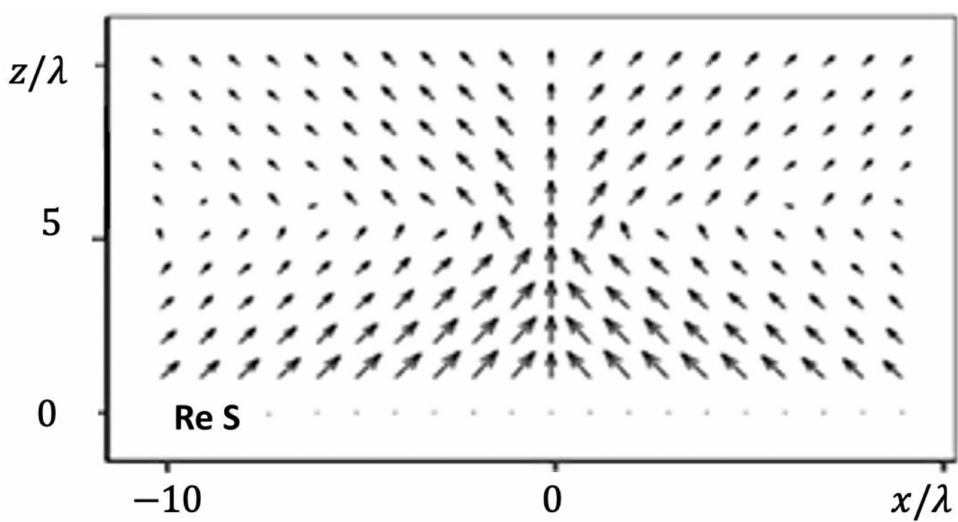
Figure 4. Spatial distribution of the real part of the Poynting vector in a lossless environment: antenna length, 10 wavelengths; focus, ( 0, 5 λ ) ; amplitude distribution, uniform.